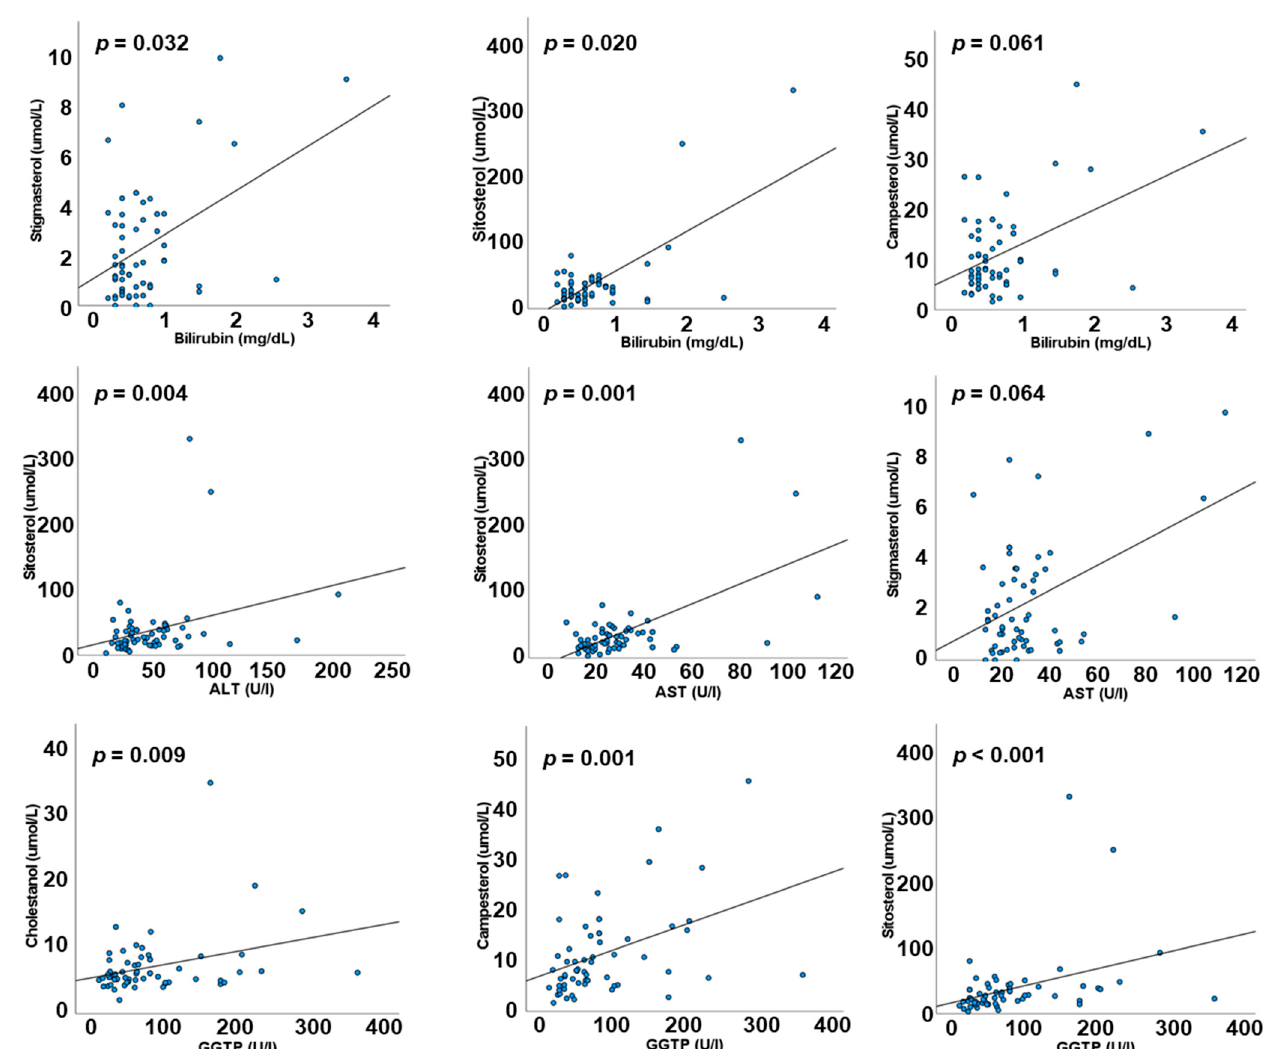
Figure 1. Correlations between liver function markers and plasma concentrations of phytosterols. Data are for all patients irrespective of lipid